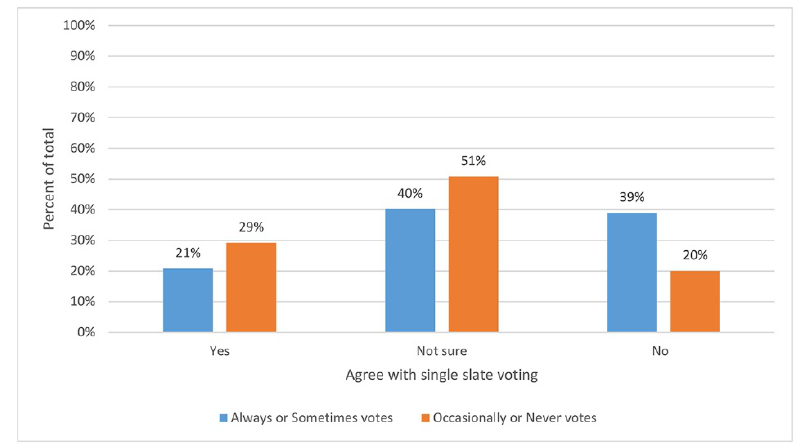
Figure 2 Association between voting frequency and opinion of a single slate*